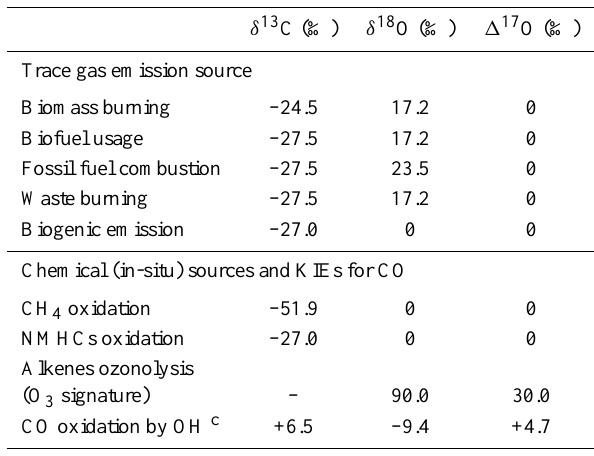
Table 2 . Emission and in-situ sources and their signatures used in the box-model simulations a , b .